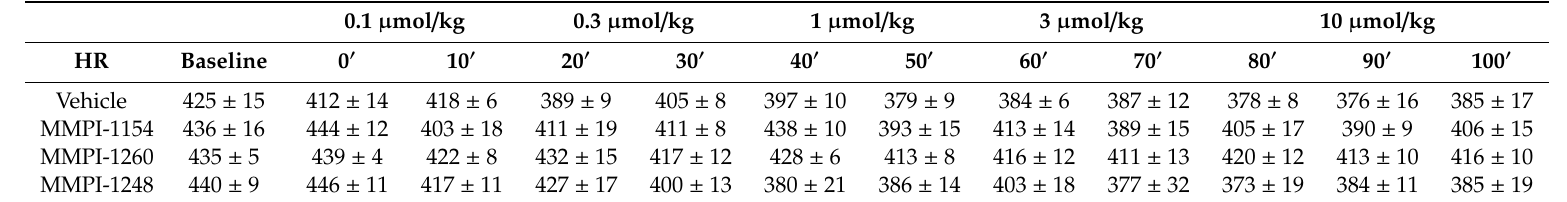
Table 2. Heart rate (beat / minute) of the animals during the tolerability